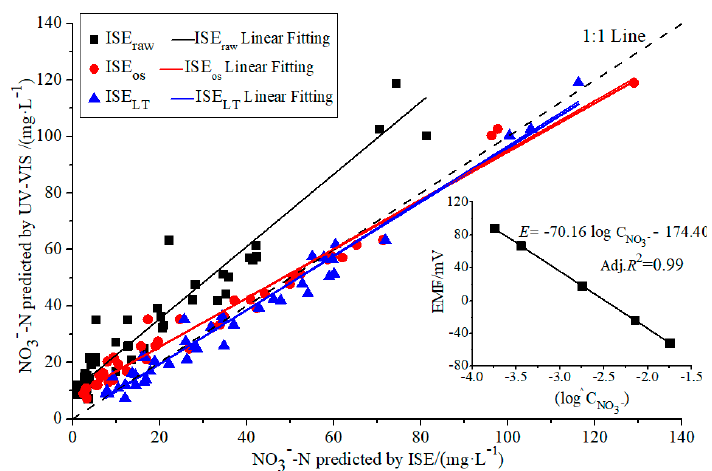
− -N predicted with ISE raw , ISE OS , and